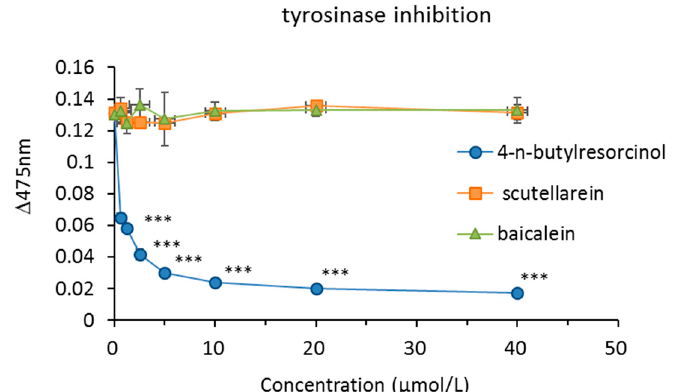
Figure 5. The effects of the tested compounds on mushroom tyrosinase activity. Mushroom tyrosinase activity was determined by calculating the absorbance change rate in 10 min at 475 nm. 4-n- butylresorcinol: 40 μ mol/L (6.64 μ g/mL), 20 μ mol/L (3.32 μ g/mL), 10 μ mol/L (1.66 μ g/mL), 5